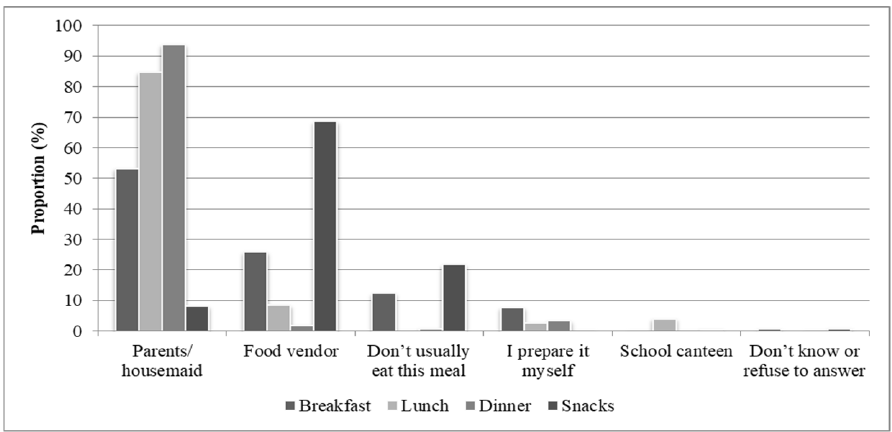
Figure 2. Proportion of meals prepared by source as reported by 1059 students from the 22 junior secondary schools in Ouagadougou.